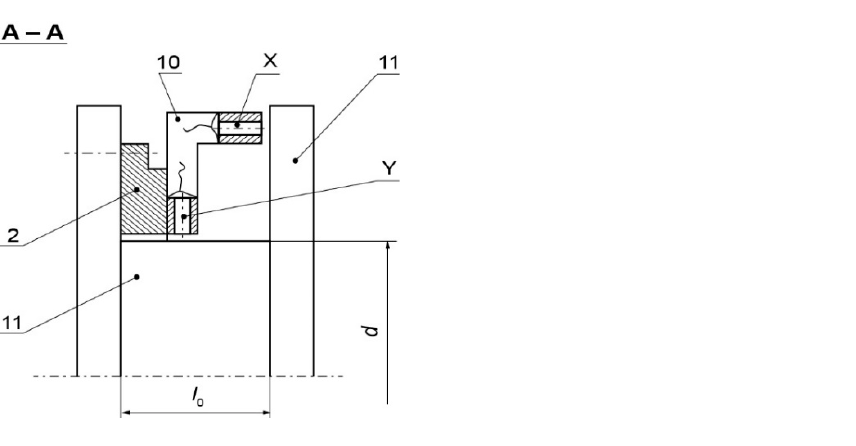
Figure 21. Configuration for calibrating the position head: 2—engine cover; 10—position head; 11—calibration bushing; d —diameter of calibration bushing equal to diameter of new shaft in the measurement plane; l 0 —distance between internal frontal surfaces of calibrating bushing flanges.